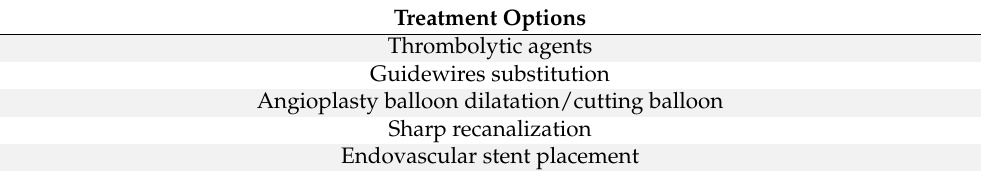
Table 1. Options of treatment for recanalization of thrombosed